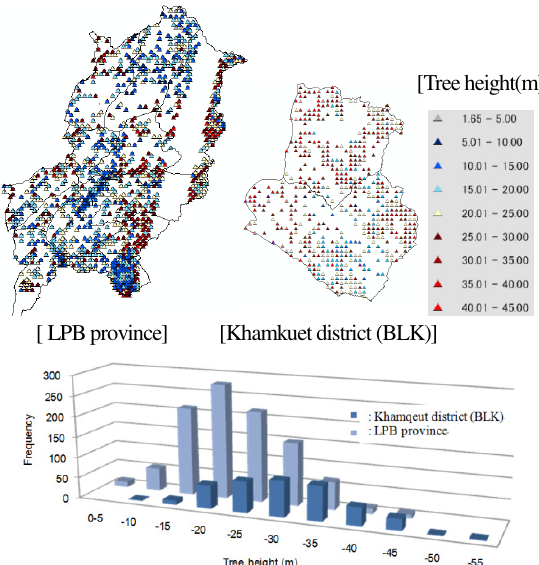
Figure 5. PRISM tree heights (LPB provin ce and Khamkuet district